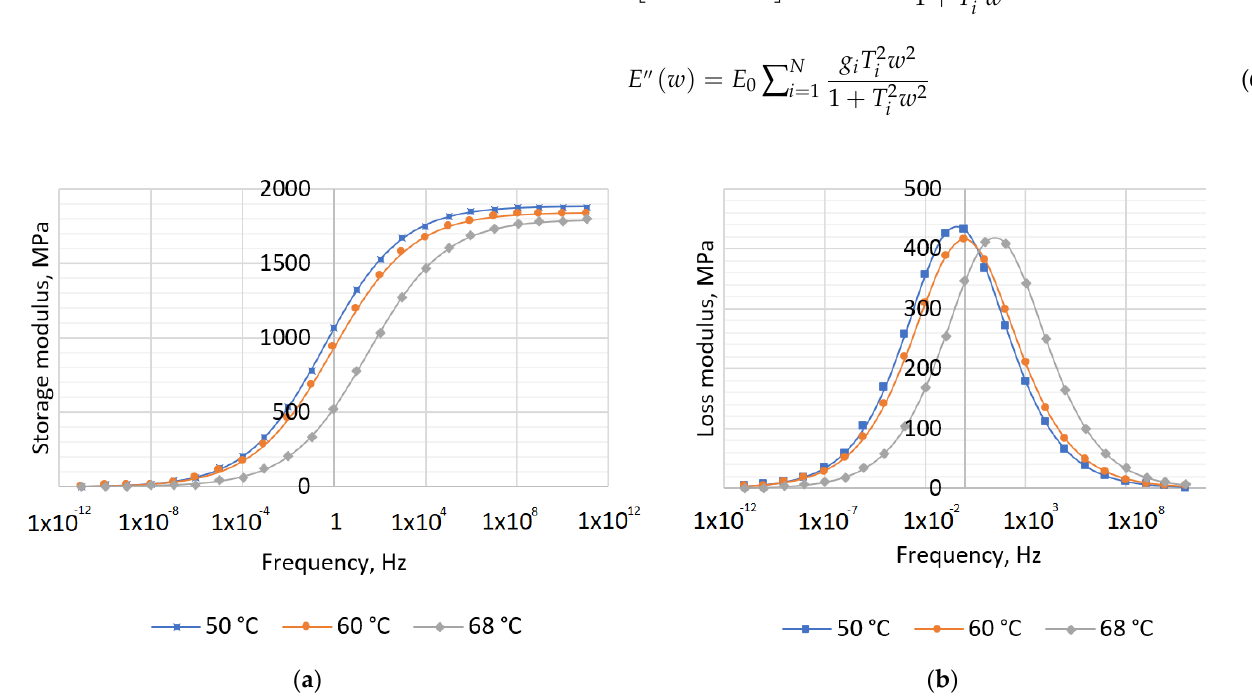
Figure 3. Master curves of ( a ) Storage modulus; ( b ) Loss modulus.